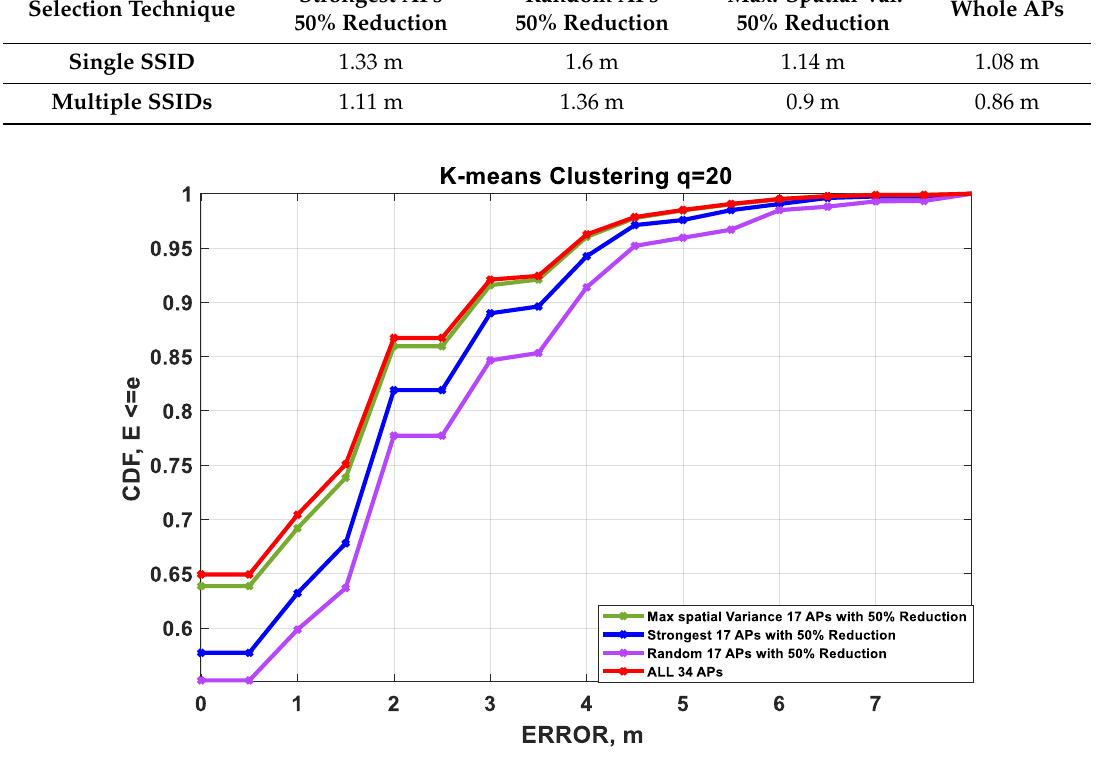
Table 5. The mean distance error of the K-means-based proposed system versus a single SSID. Selection Technique